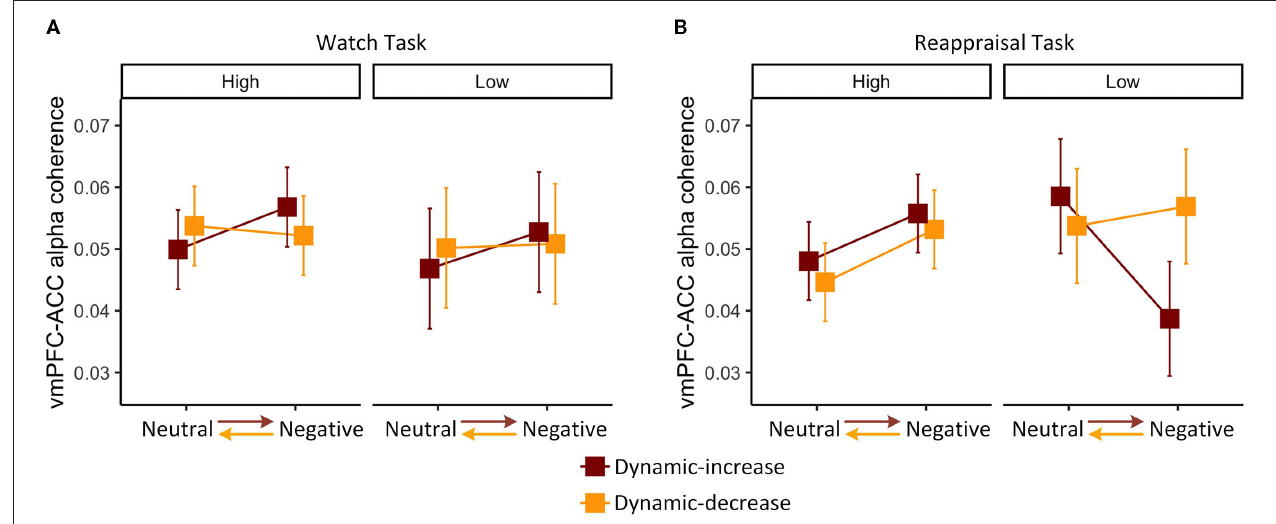
FIGURE 4 | Three-way interaction plot of model estimates of content, context, and habitual reappraisal (high vs. low: mean ± 1 SD ) on the alpha band FC between vmPFC and ACC in the (A) watch task and (B) reappraisal task. Error bars are standard errors.